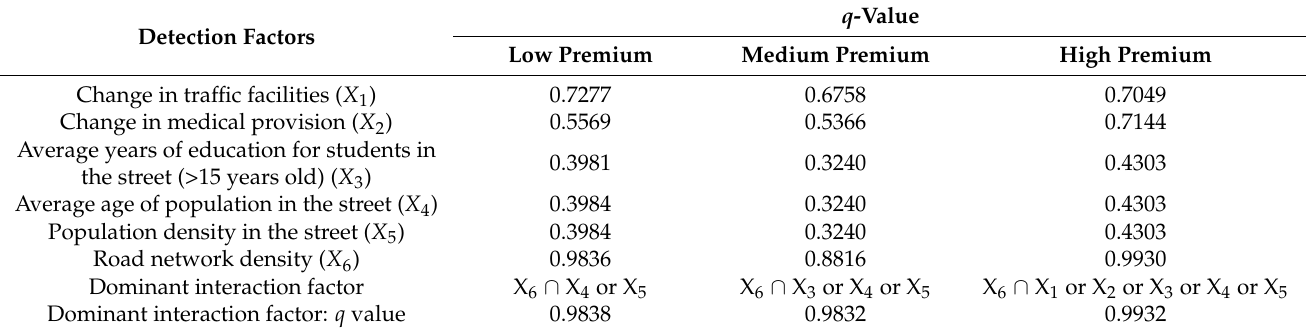
Table 5. Results for Geo-detector analysis.